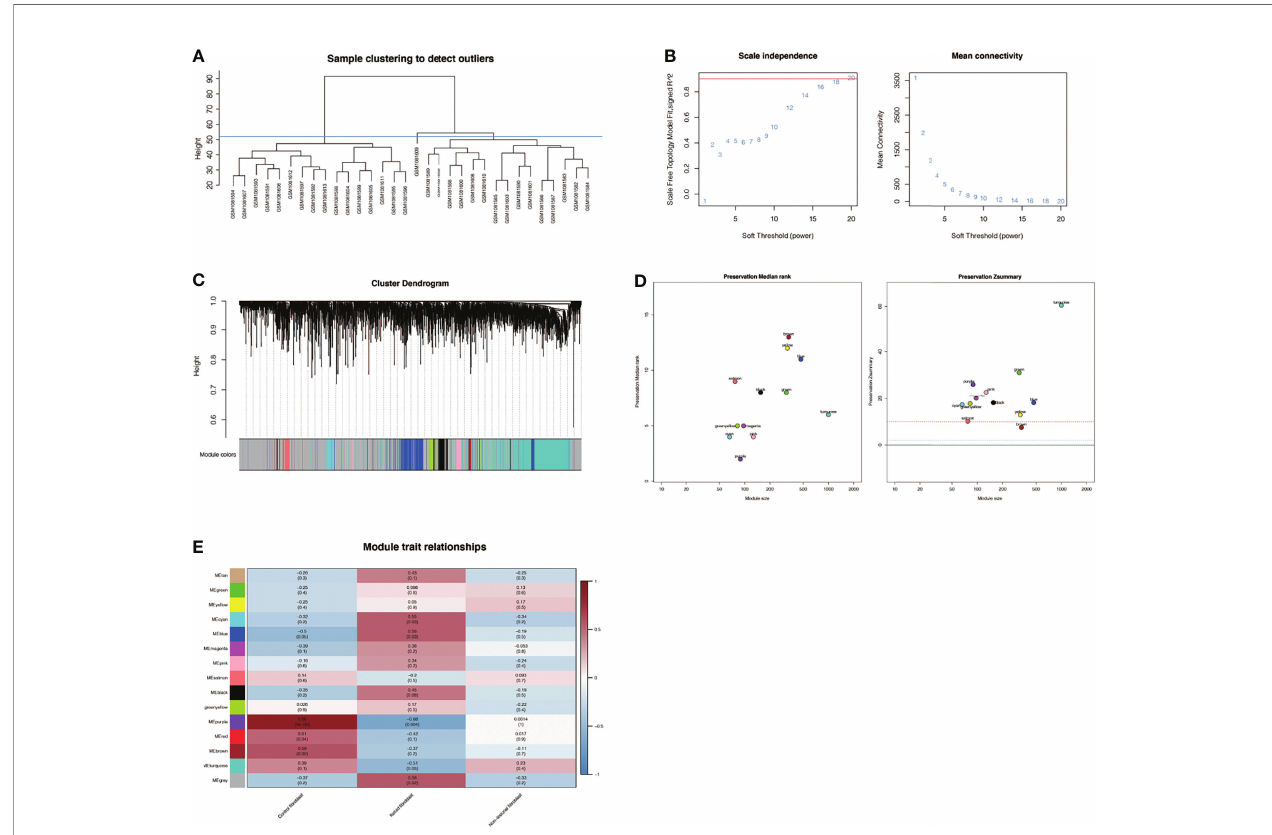
FIGURE 5 | Weighted co-expression network analysis in GSE44270. (A) Sample clustering of dataset GSE44270. The samples were clustered into two signi fi cantly different clusters. The cluster on the left is selected for subsequent analysis. (B) Selection of optimal thresholds. The threshold is 18. (C) By aggregating genes with strong correlations into the same module, different modules are obtained and displayed in different colors. Turquoise modules account for a larger proportion. (D) Veri fi cation of the accuracy of WGCNA results. (E) Correlation analysis between modules and keloid. Purple module was signi fi cantly positively correlated with normal skin fi broblasts (NF) (COR= 0.86,P <0.001) and negatively correlated with keloid fi broblasts (KF) (COR = -0.68,P <0.01). The genes in the purple module were labeled as the WGCNA-hub